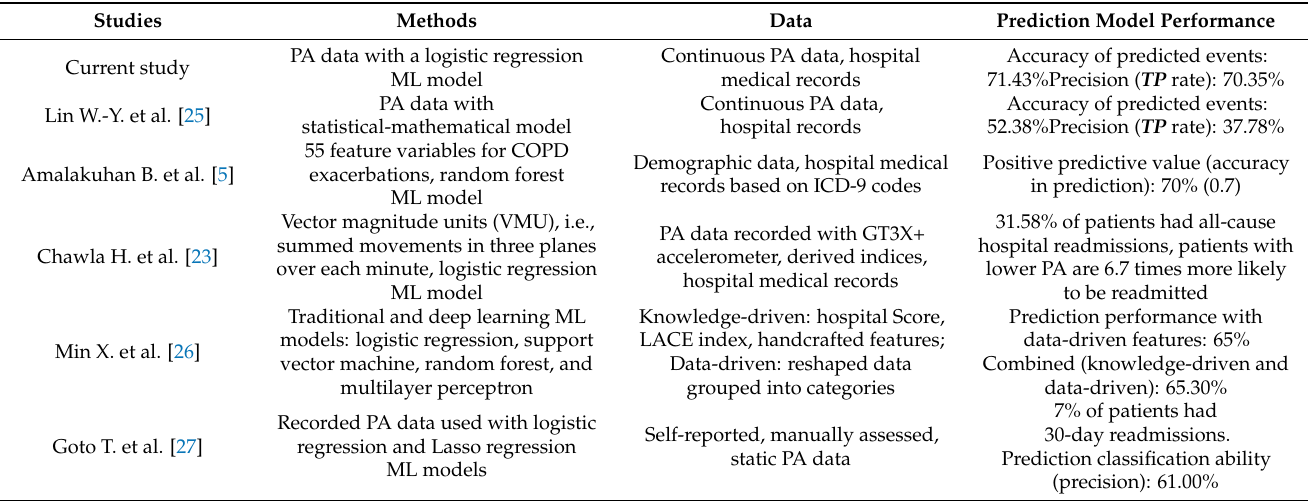
Table 3. Performance of 30-day hospital readmission prediction